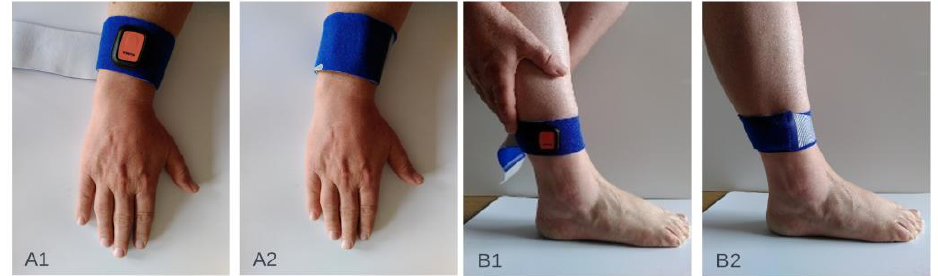
Figure 2. Attachment sites of the inertial sensor units on the upper extremity ( A1 , A2 ) and the lower extremity ( B1 , B2 ).